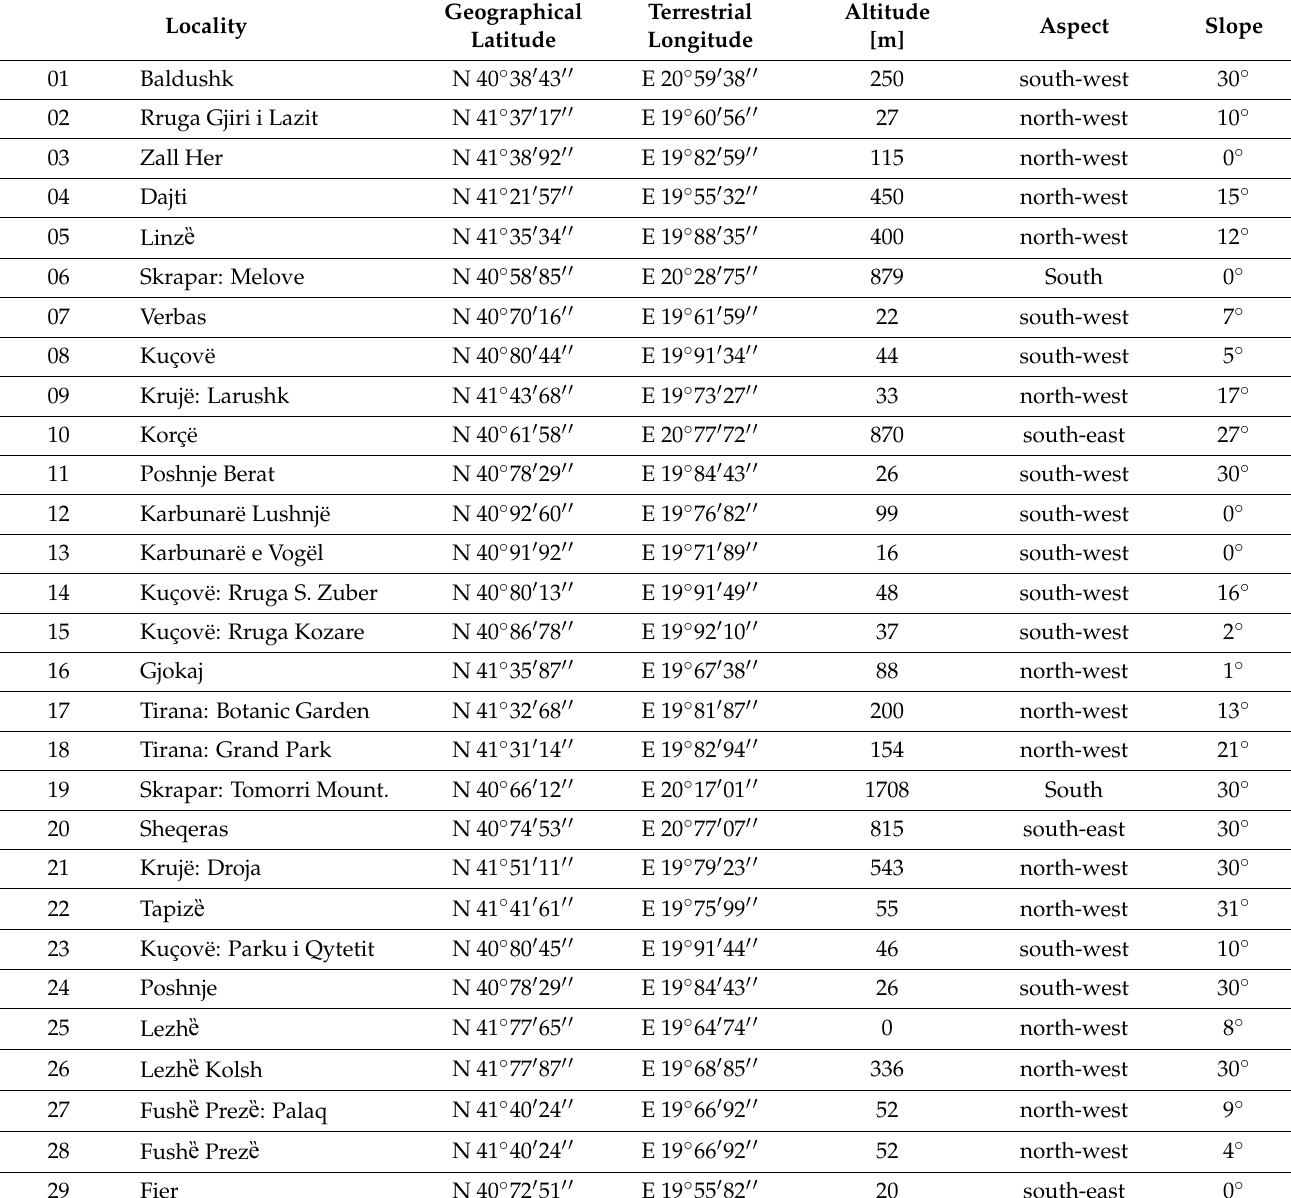
Table 1. The basic characters of selected sites in Albania with the occurrence of chamomile